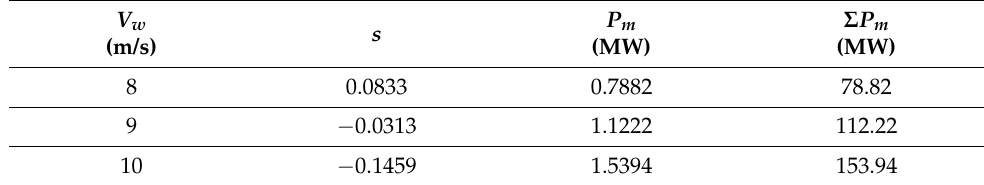
Table 6. Generator slip and turbine